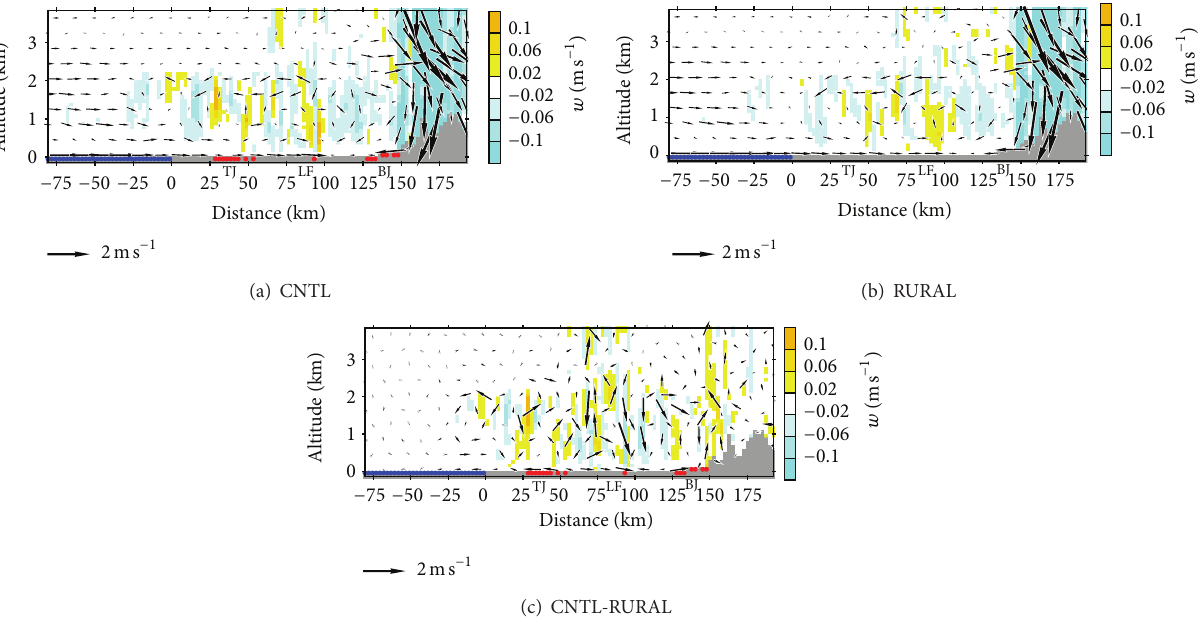
Figure 12: Similar to Figure 11, but for the vector fields at 2100 LST 24 August, (a) CNTL, (b) RURAL, and (c) CNTL-RURAL. The three cities from left to right are Tianjin (TJ), Langfang (LF), and Beijing (BJ), respectively. Please refer to Figure 11 for more details of the figure